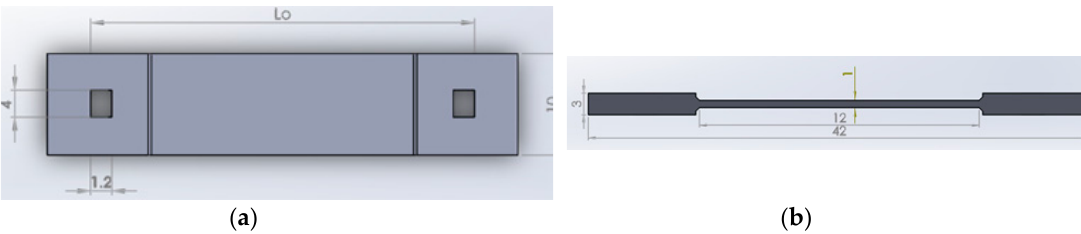
Figure 10. Dimensions of the dog-bone-shaped metal (Lo = 29.24 mm). ( a ) Top view; ( b ) Side view.